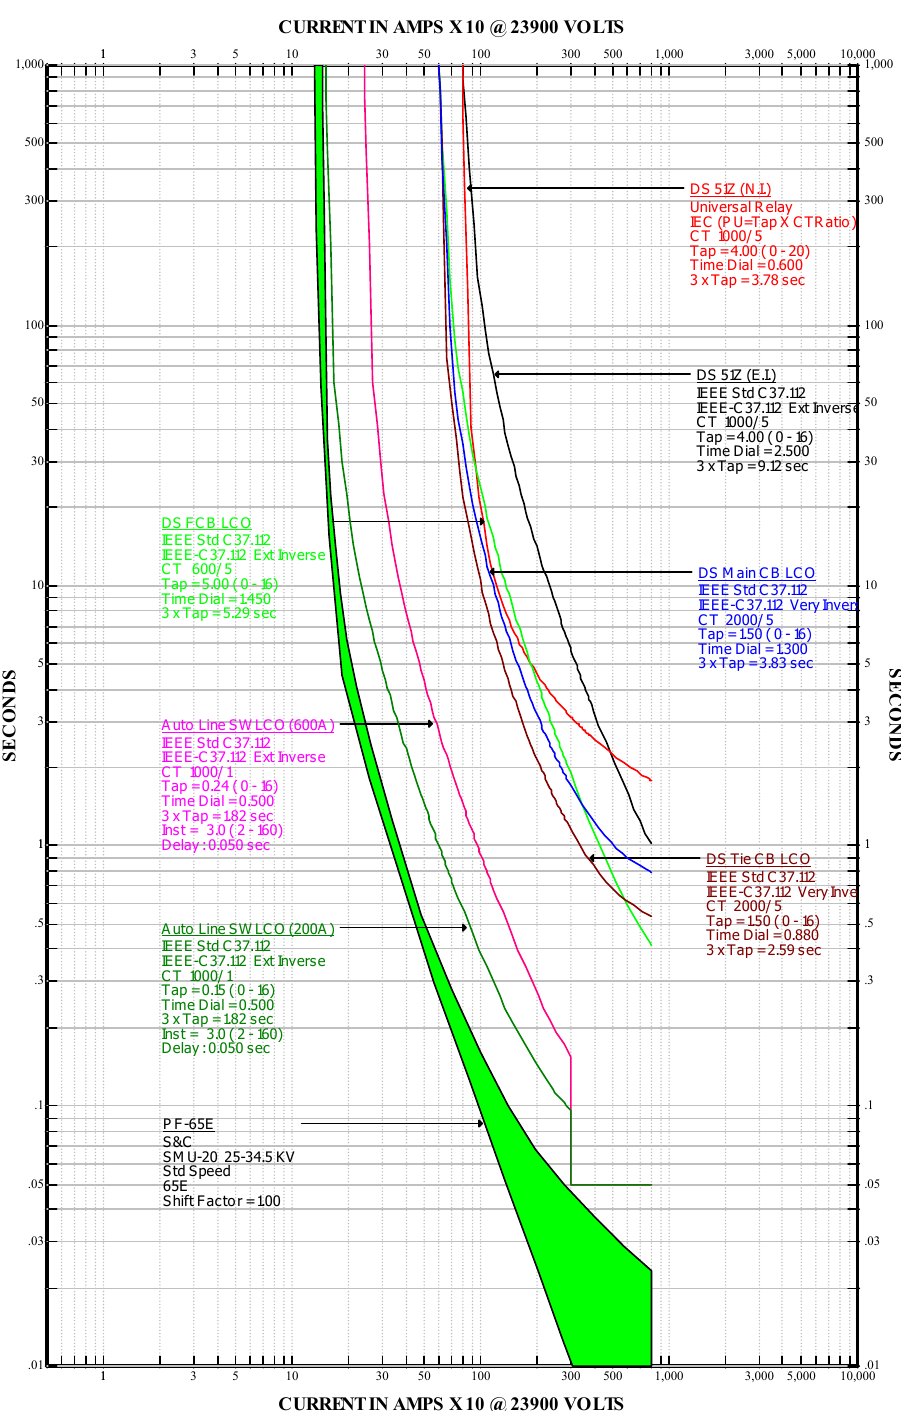
Figure 9. Proposed LCO relays of Minsheng